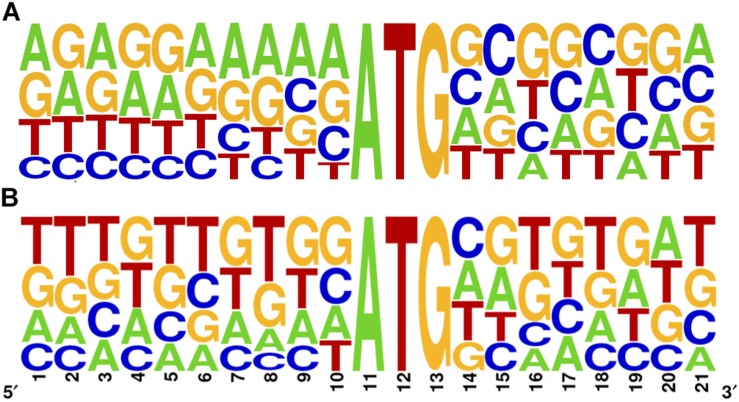
Sequence logo of the AUG initiator sequence in T. cruzi. 10 base pairs surrounding the A in position +1 are shown for the main CDS (A) and for the longest uORFno (B). Context logo were generated with WebLogo (Crooks et al., 2004).